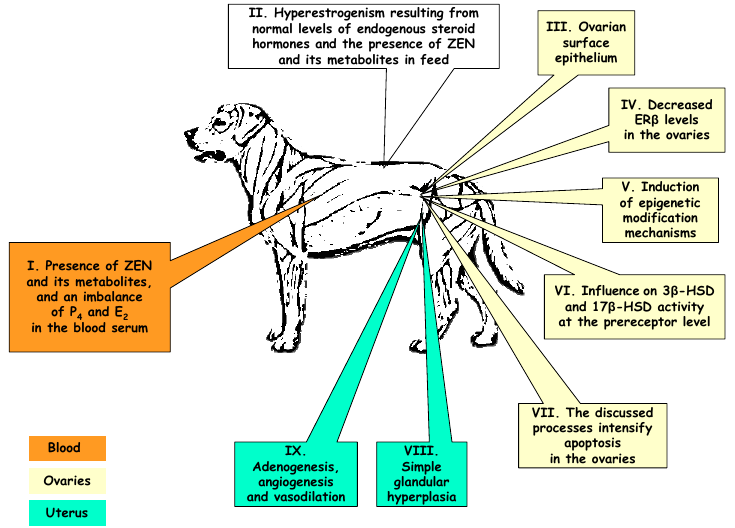
Figure 4. Preliminary determination of the diagnostic significance of selected analytical indicators of mycotoxicosis induced by zearalenone (at dose NOAEL) in bitches.